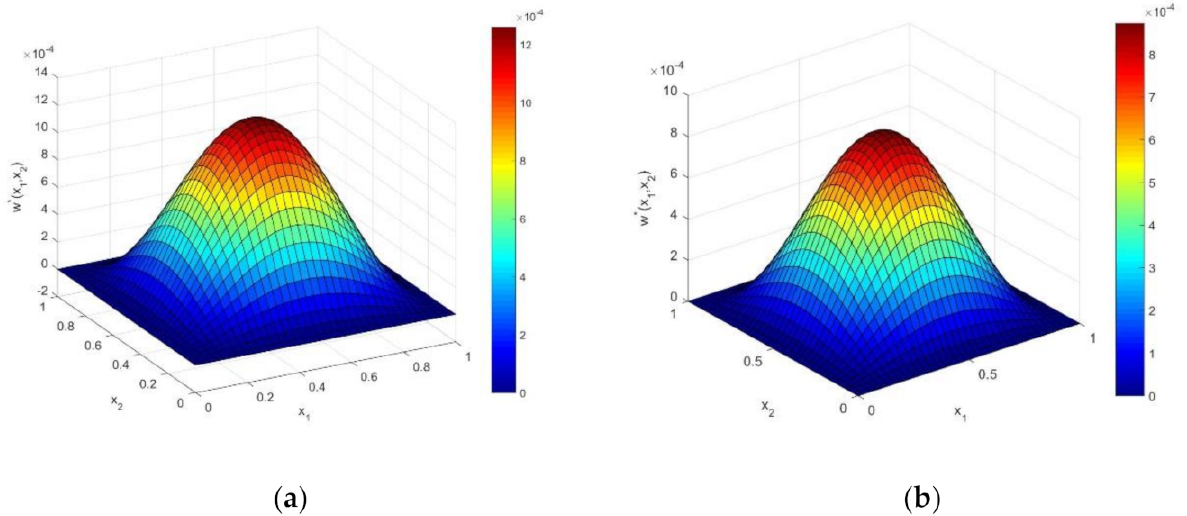
Figure 4. Three-dimensional map of deflections for ( a ) homogeneous plate and ( b ) transversally graded FGM plate with gradation parameters ζ = 1, p = 1.